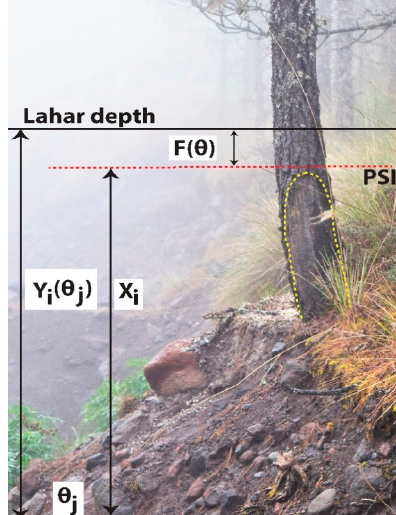
Figure 4. Assessment of deviations between observed paleostage indicators (PSI) and lahar depths modelled with rapid mass movement simulation (RAMMS) for the 2012 lahar: X i represents observed values (i.e., impact scars on trees) at position i ; and Y i ( θ j ) gives the computed water depth for a given roughness θ j . Deviation between both values is represented by F ( θ ).